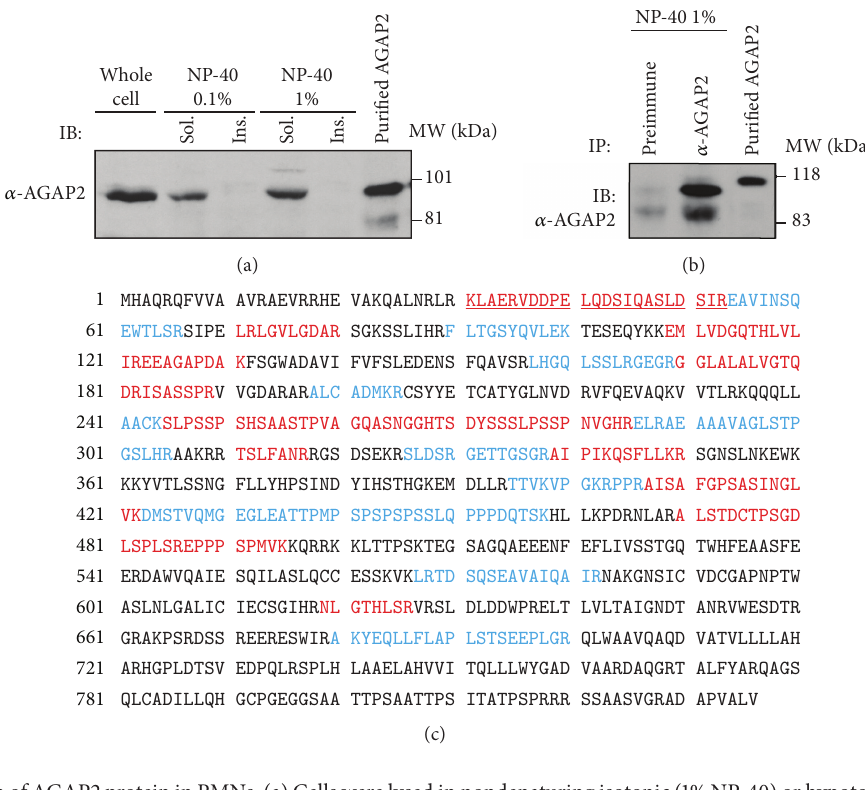
Figure 5: Expression of AGAP2 protein in PMNs. (a) Cells were lysed in nondenaturing isotonic (1% NP-40) or hypotonic (0.1% NP-40) lysis buffer. (b) PMNs were lysed in nondenaturing isotonic lysis buffer and AGAP2 was immunoprecipitated with preimmune serum or immune serum raised against AGAP2. Cell lysates derived from 1.5 × 10 6 PMNs (a) and immunoprecipitates (b) were resolved by SDS-PAGE. Purified His6-tagged AGAP2 was used as a control. (c) Amino acid sequence of human AGAP2 (NCBI Reference Sequence: NP 055585.1). AGAP2 was immunoprecipitated from PMNs (4 × 10 7 /mL) as described in (b). The samples were resolved using 7.5–20% SDS-PAGE and the gel was stained with SYPRO Ruby. Bands of interest were analysed by mass spectrometry. The peptides identified by mass spectrometry are in red or blue. Peptides unique to AGAP2 are